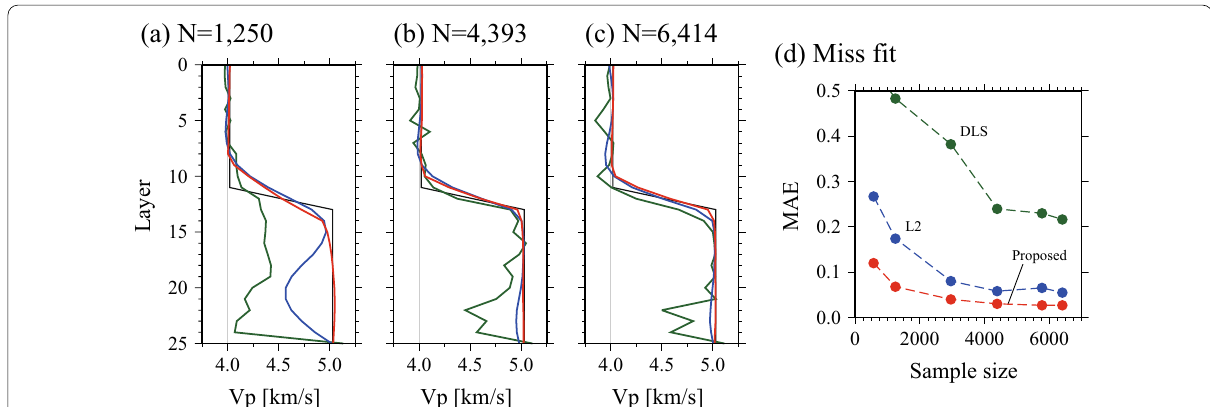
Fig. 8 Recovery of the estimated average velocities by changing the number of arrival time data used in the analysis: a 1250; b 4393; and c 6414, which are about one-half, twice, and three times the number used in the main results, respectively. d MAE variations in the sample sizes for the estimation methods. The colored lines in a – c are the same as those in Fig.